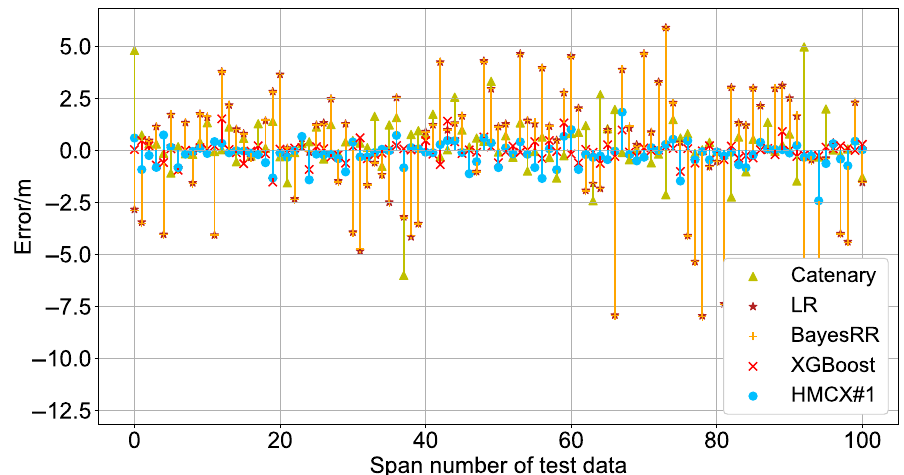
Figure 14. Sag estimation results of cluster #1.